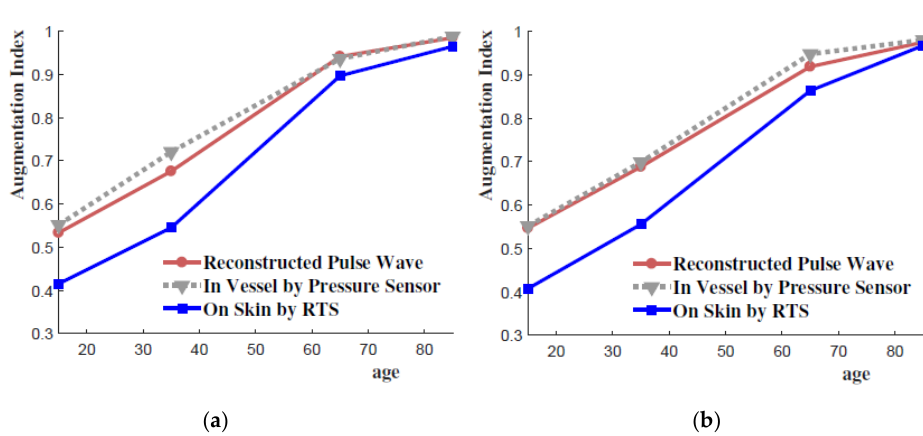
Figure 11. Comparison of AI of pulse pressure waveforms: ( a ) 650 ms heart rate, ( b ) 750 ms heart